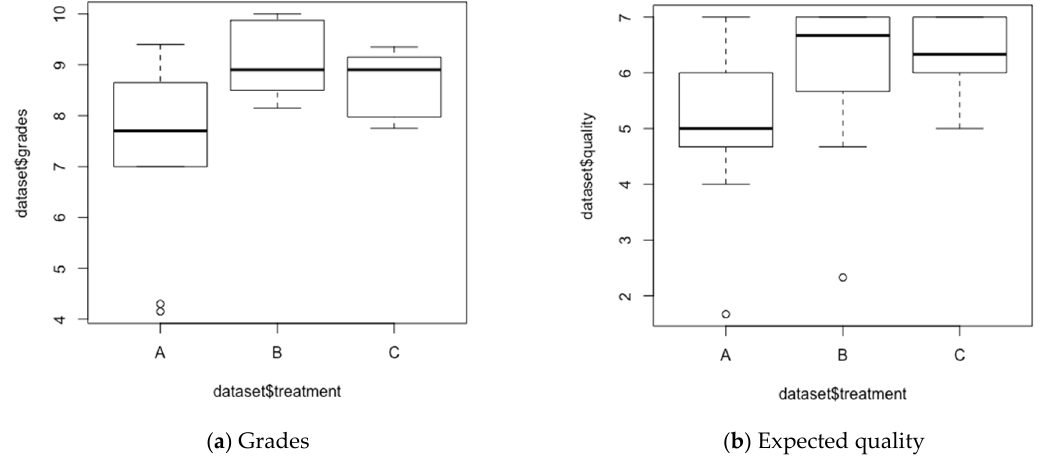
Figure 4. Boxplots contrasting group composition.